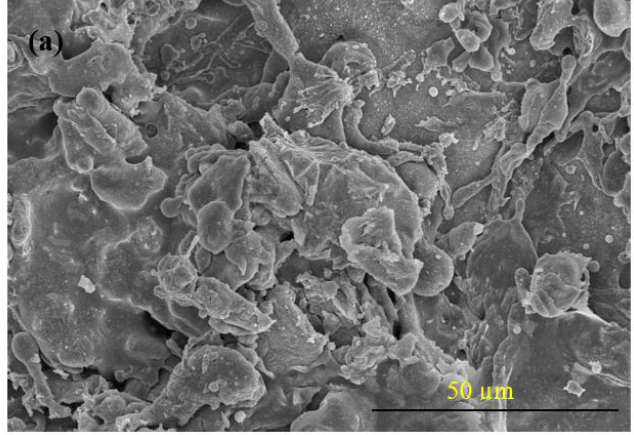
Z n Figure 4. ( a ) SEM of top surface, ( b ) SEM of cross section, and ( c ) XRD of Zn – Al coating. 3.3. Evaluation of Electromagnetic Wave Shielding Performance of the Concrete The electromagnetic shielding performance of the concrete specimens with different amounts of carbon black at a particular thickness is shown in Figure 5a, while Figure 5b show the results of a